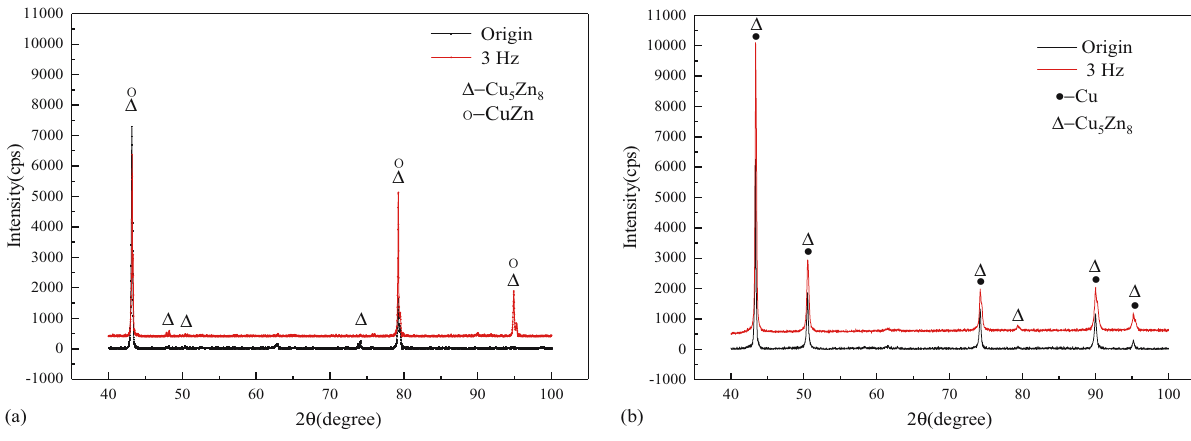
Figure 4: Phase analysis of brass alloy with and without EPT ( a ) without corrosion and ( b ) with corrosion.